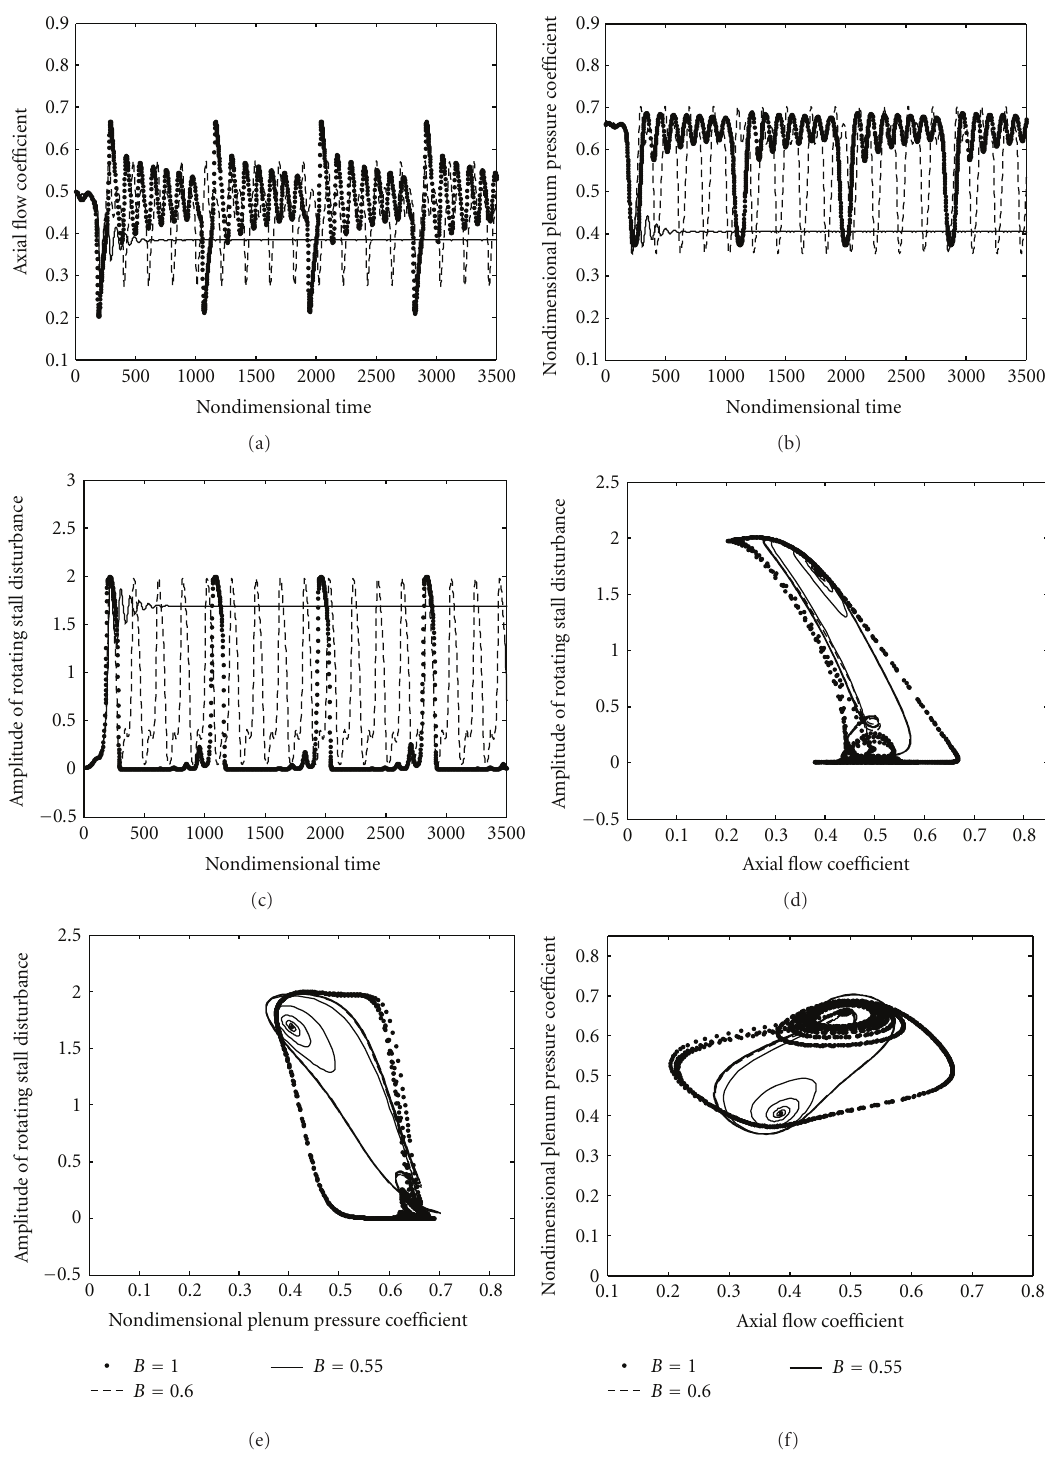
Figure 12: E ff ect of decrease in B parameter: variation of nondimensional flow properties (a), (b), and (c) with time. (a) Axial flow coe ffi cient. (b) Plenum pressure rise coe ffi cient, and (c) disturbance amplitude of rotating stall. (d) Variation of axial flow coe ffi cient with disturbance amplitude of rotating stall. (e) Variation of plenum pressure rise coe ffi cient with disturbance amplitude of rotating stall. (f) Limit cycle oscillation: axial flow coe ffi cient versus plenum pressure rise coe ffi